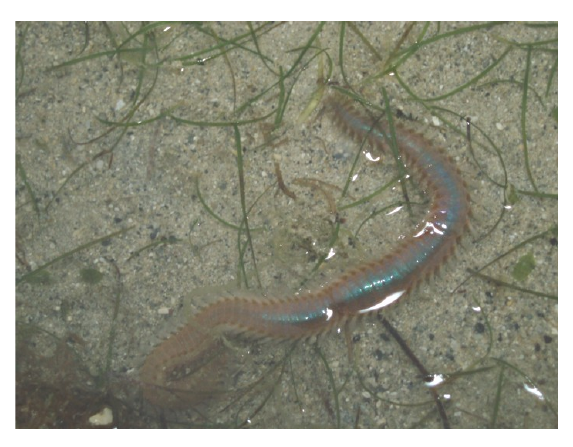
Figure 2: Marine fireworm Eurythoe complanata (body length 10 cm).